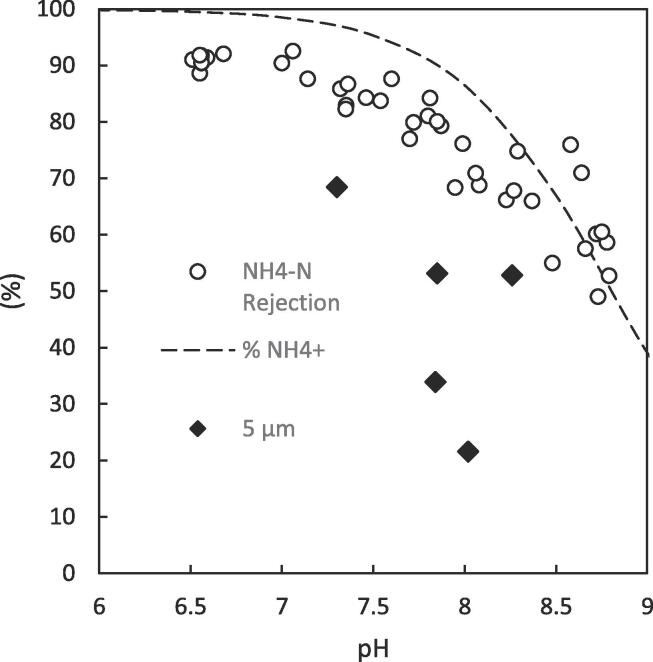
Collation of data for the rejection of ammoniacal nitrogen by AGMD at various faecal concentrations and membrane pore sizes. The data for the membrane of 5 μm pore size has been highlighted due to its deviation from the %NH4+ ratio as a result of membrane wetting. (Tf,i = 40 °C, Tp,i = 20 °C).